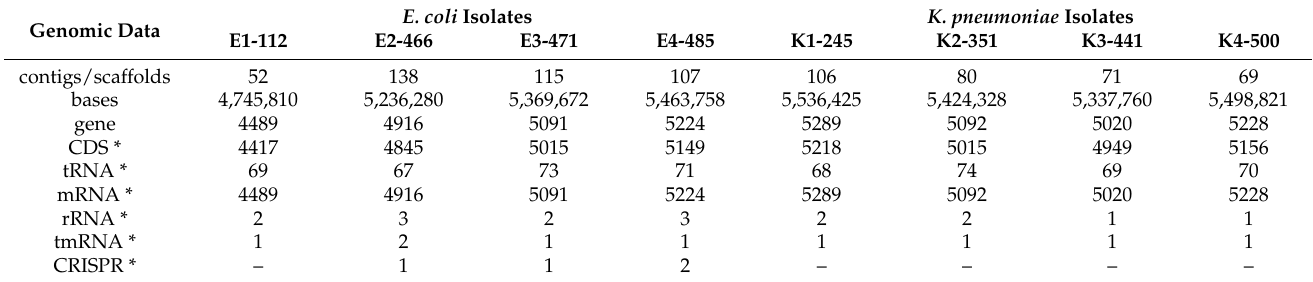
Table 4. Annotation of draft genome of Escherichia coli and Klebsiella pneumoniae isolates. Genomic